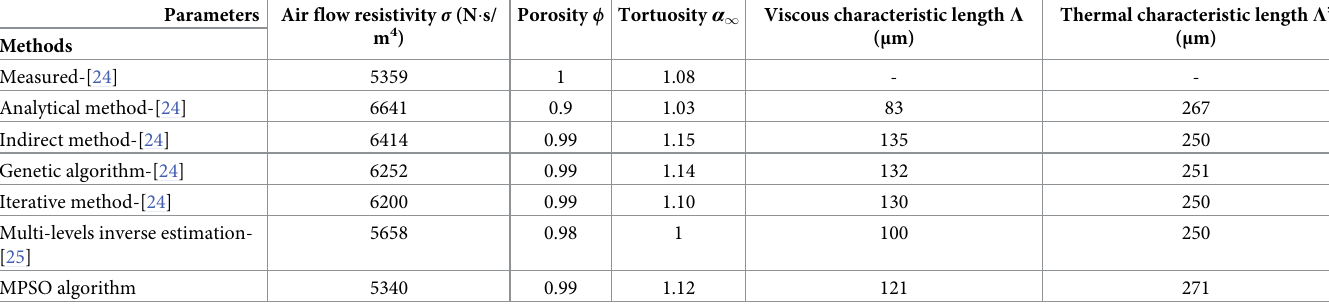
Table 1. Parameter values measured and identified by the above mentioned